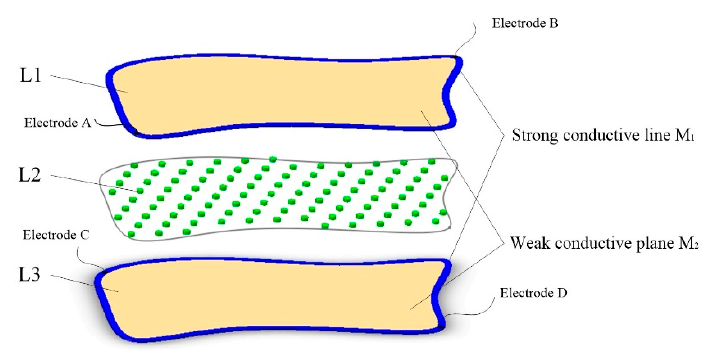
Figure 1. Structure of the tactile sensor.